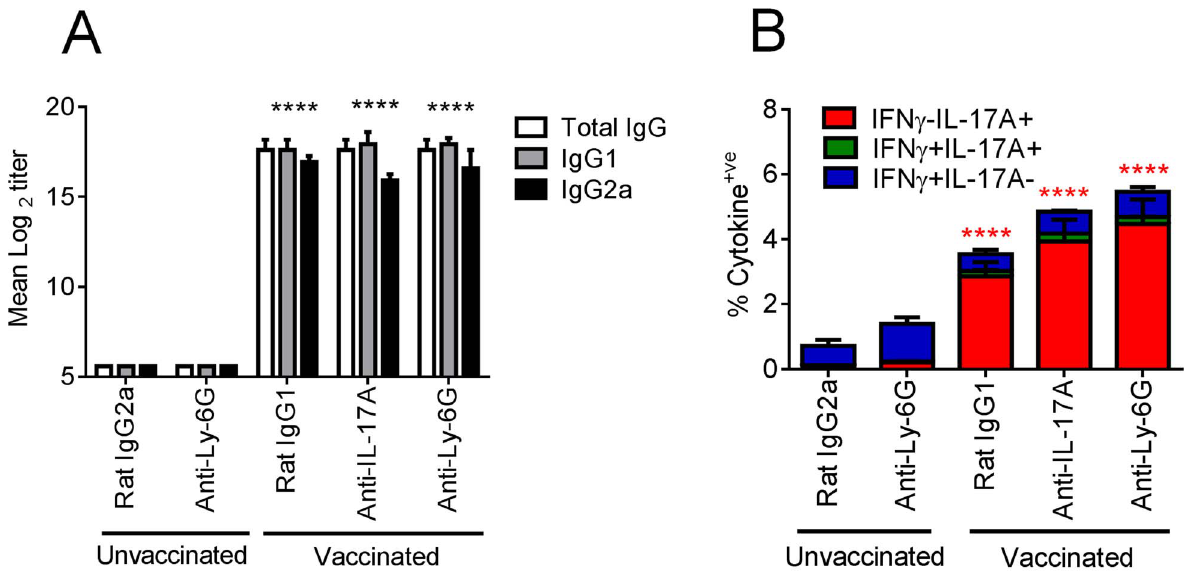
Figure 6. Adaptive immunity is unaffected by IL-17A blockade or neutrophil depletion following viral challenge. Mice vaccinated intranasally with split influenza virus antigen (A/Uruguay/716/2007 (H3N2)) and CRX-601 were administered with anti-Ly-6G (IA8) or anti-IL-17A (100 m g) i.p. one day prior to challenge with influenza and then daily for a further 6 days post challenge. Serum influenza virus specific antibody titers (A) and lung T cell responses (B) were evaluated 5 days post influenza challenge. **** in Figure 6A denotes significance of IgG subtypes compared to unvaccinated IgG2a control using a One-way ANOVA, Dunnet post test. In Figure 6B, **** denotes significance compared to the unvaccinated IgG2a control group using a two-way ANOVA- (Bonferroni- Post-test). Data are means 6 SEM for five (A) or three (B) replicates